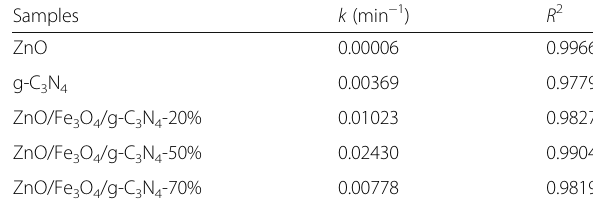
Table 2 First order kinetic constants and relative coefficients for photocatalytic degradation of MO over the samples